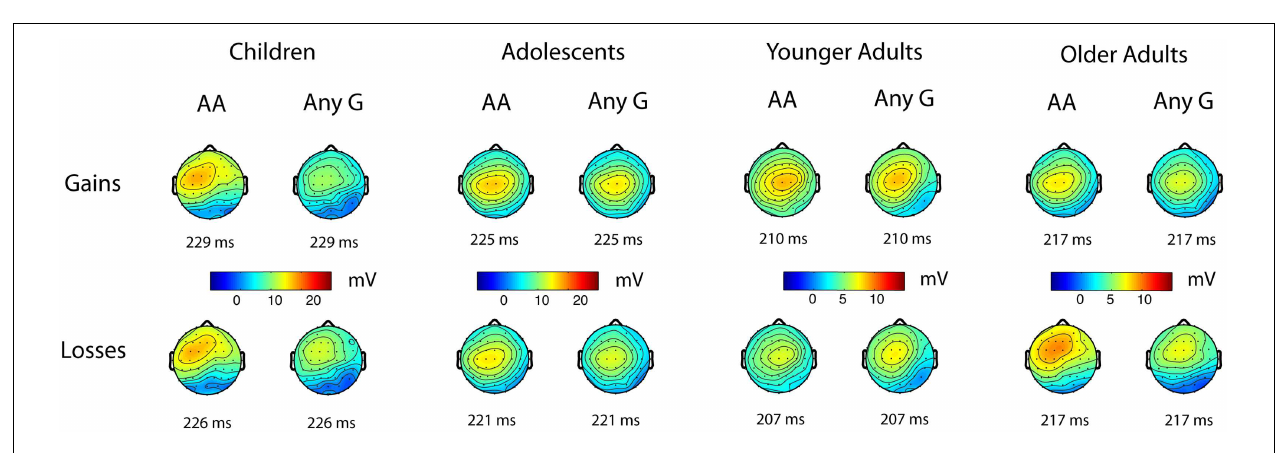
FIGURE 1 | (A) Grand average of the stimulus-locked ERPs to positive and negative feedback for the AA (higher striatal dopamine receptor efficacy) and “any G” genotypes (lower striatal dopamine receptor efficacy) for rs907094